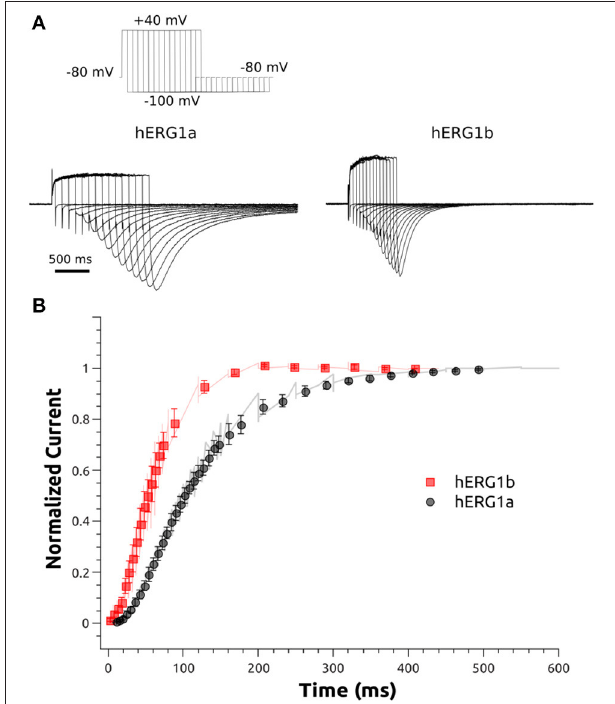
FIGURE 4 | Activation kinetics of hERG1a and hERG1b channels expressed in HEK cells. An envelope of tails protocol was used to measure the activation properties at + 40mV. (A) Representative current traces elicited by the protocol shown at the top corresponding to 5–500ms of activation are shown. (B) The data were normalized to the maximum amplitude of the tail current and plotted against time. hERG1a ( n = 10); hERG1b ( n = 10). All data are shown as mean ±